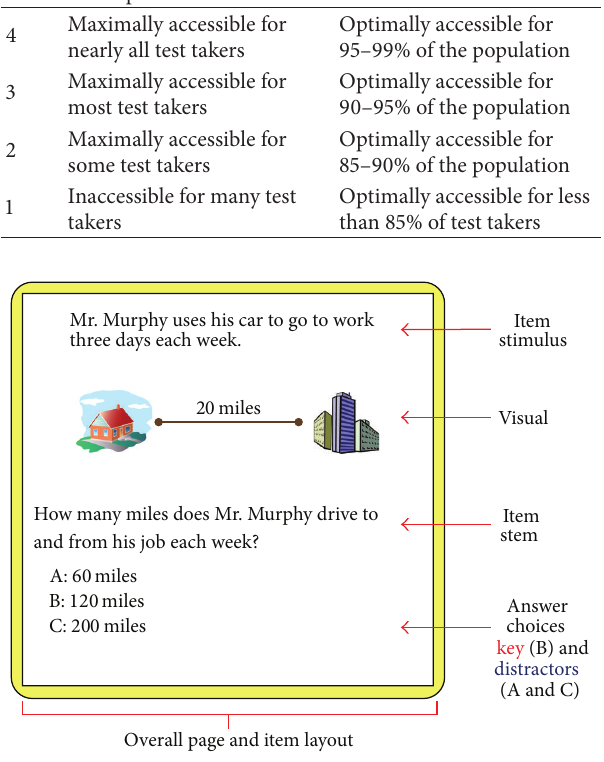
Figure 2: Anatomy of a multiple-choice item ([16, 17], used with